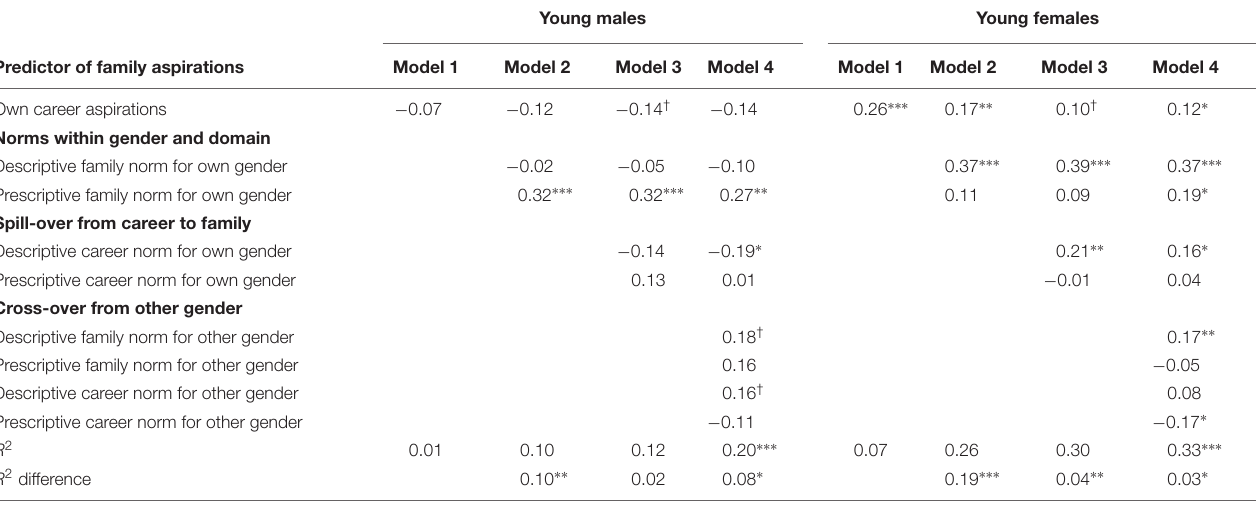
TABLE 4 | Hierarchical regression models predicting young male and female participants’ family aspirations from different gender norms (standardized